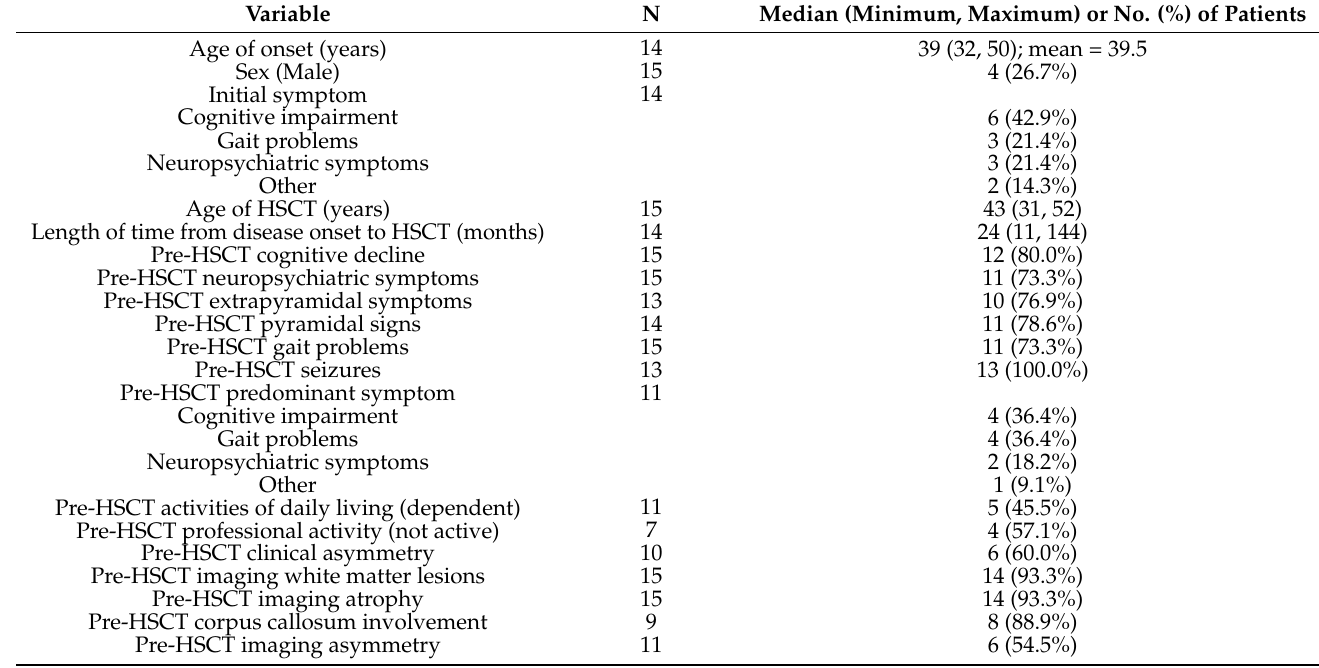
Table 2. Summary of patients’ demographics and pre-HSCT characteristics.